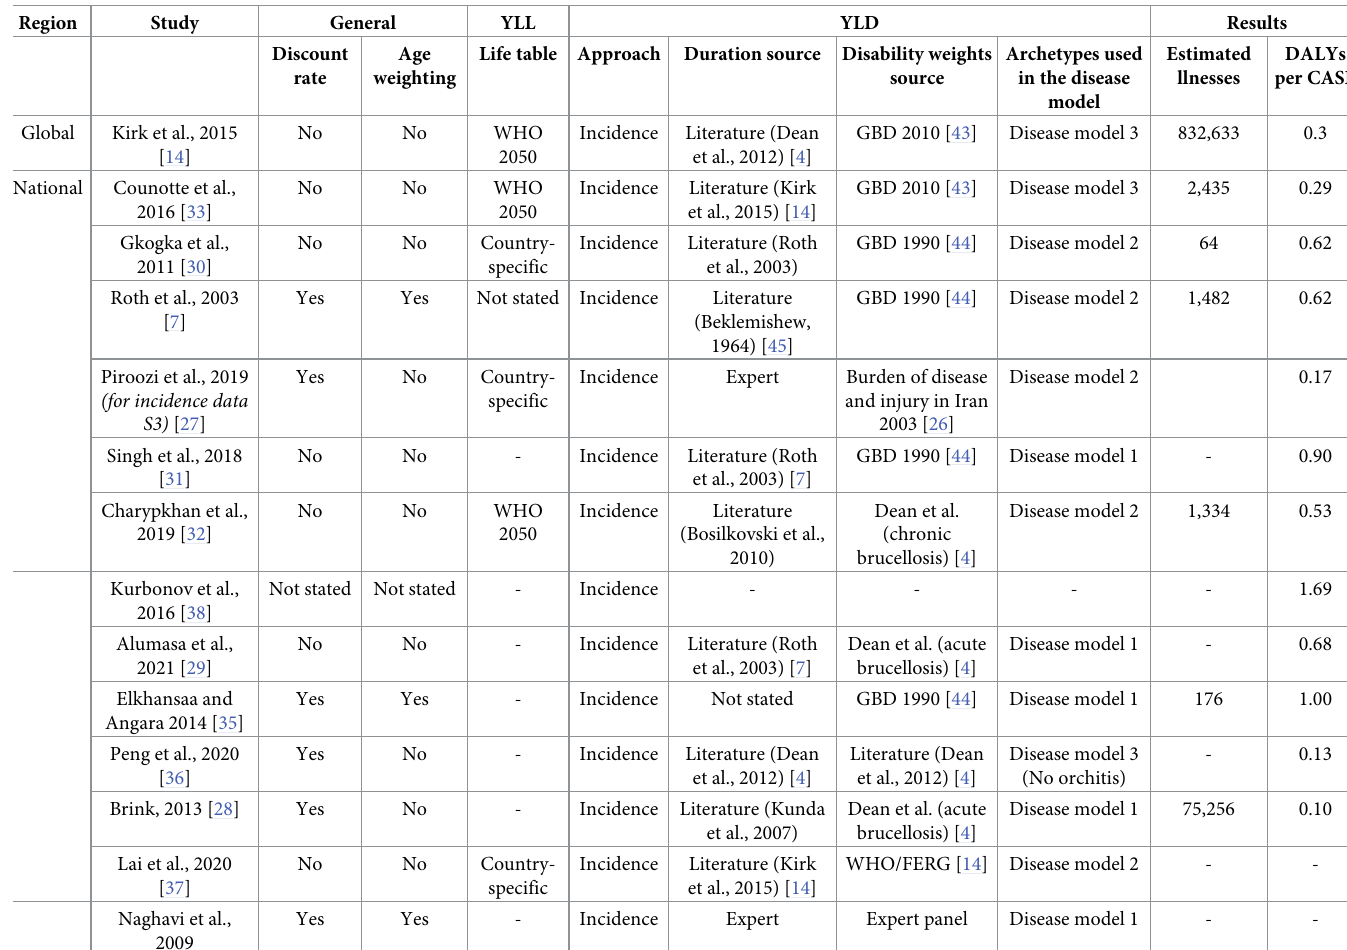
Table 1. Summary of disability-adjusted life year calculation methods for